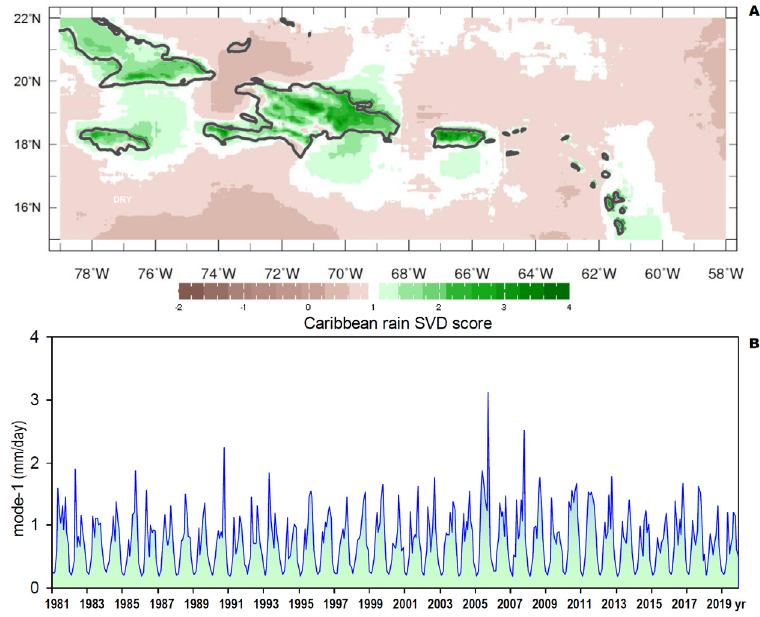
Figure 3. ( a ) Loading map for SVD mode-1 CHIRP rainfall and ( b ) its associated mode-1 time score.